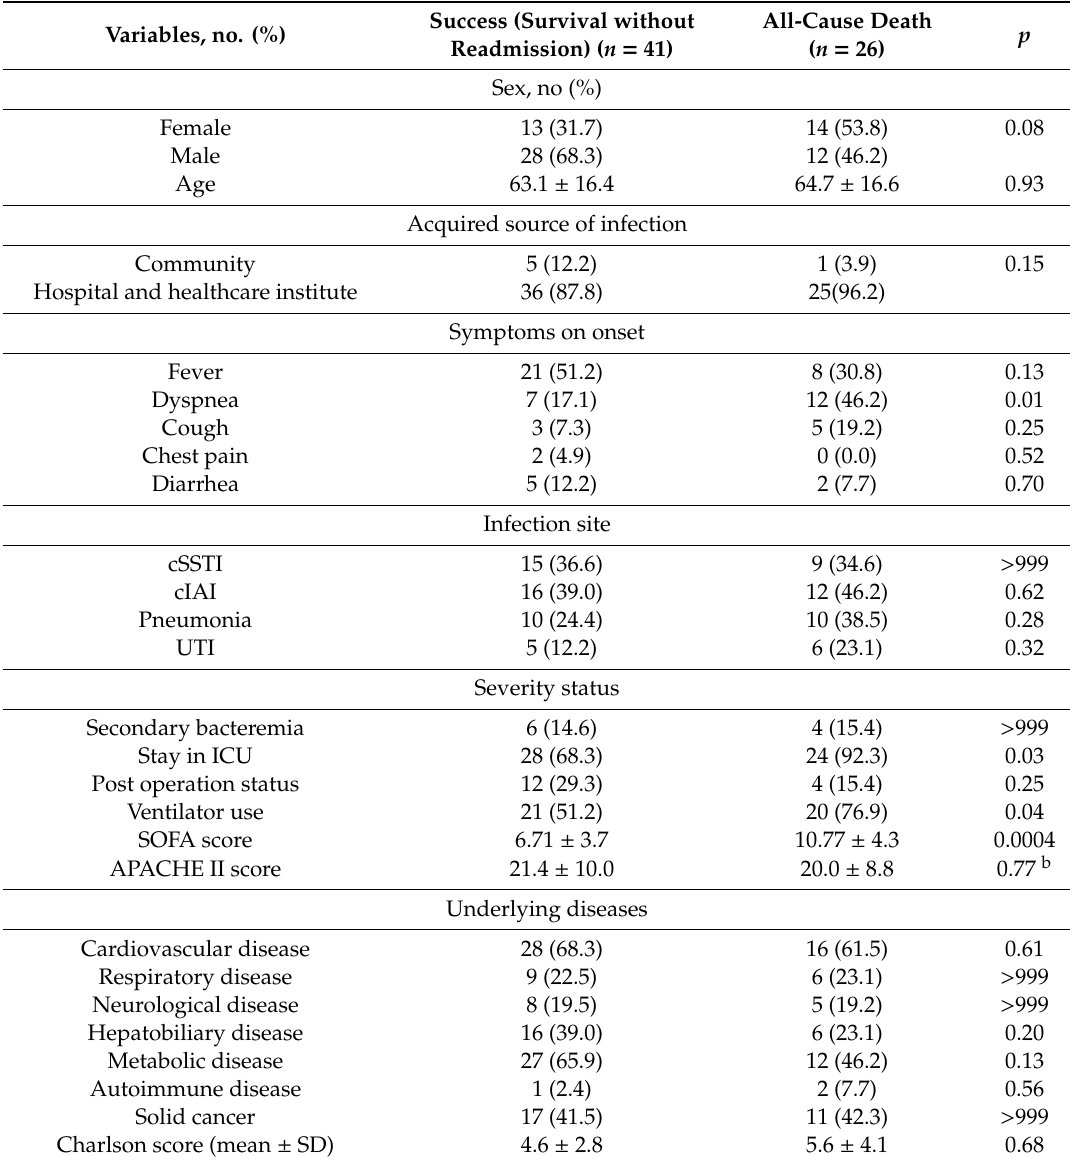
Table 3. Predictors for the clinical outcome by 30 days after the end of therapy (EOT) a.